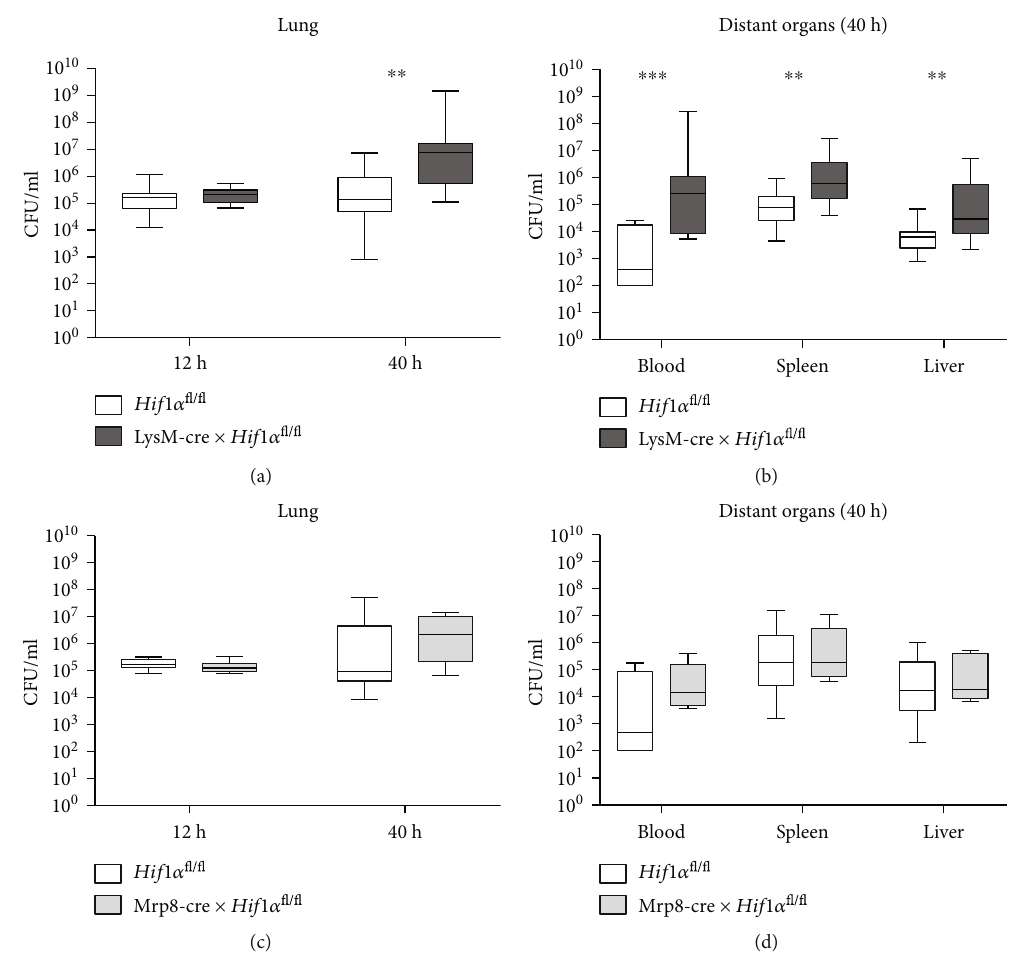
Figure 2: Macrophage HIF1 α is important for host defense against K. pneumoniae in the lung. Bacterial loads (CFU/ml) in the lungs of LysM- cre × Hif1 α fl / fl mice and littermate controls 12 and 40 hours after intranasal inoculation with ~ 10 4 CFU K. pneumoniae (a) or in distant organs 40 hours after inoculation (b). Data are shown as box-and-whisker diagrams of 13-16 mice per group from two independent experiments for each time point. Bacterial loads (CFU/ml) in the lungs of Mrp8-cre × Hif1 α fl / fl mice and littermate controls 12 and 40 hours after intranasal inoculation with ~ 10 4 CFU K. pneumoniae (c) or in distant organs 40 hours after inoculation (d). Data are shown as box-and-whisker diagrams of 7-8 mice per group at each time point. Bacterial loads of the LysM-cre × Hif1 α fl / fl mice were compared to those of littermate control ( Hif1 α fl / fl ) mice using the Mann-Whitney test. ∗ P < 0 : 05 ; ∗∗ P < 0 : 01 ; ∗∗∗ P < 0 : 001